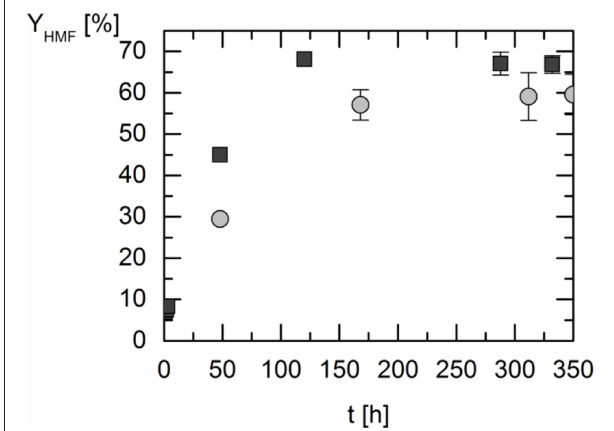
FIGURE 2 | 5-Hydroxymethylfurfural (HMF) yield over time in the different deep eutectic systems based on tetraethyl ammonium chloride (TEAC); reaction temperature: 323K; w FRU,0 = 2.5 wt.%; pressure: 1 bar. Circles: TEAC:lactic acid 1:2; squares: TEAC:levulinic acid 1:2. Data listed in Table S3